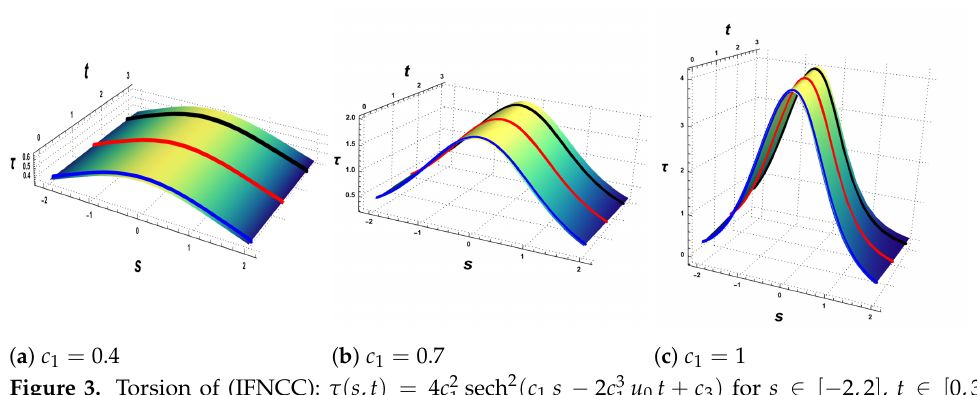
µ 0 t + c 3 ) for s ∈ [ − 2,2 ] , t ∈ [ 0,3 ] , sech 2 ( c 1 s − 2 c 3 1 1